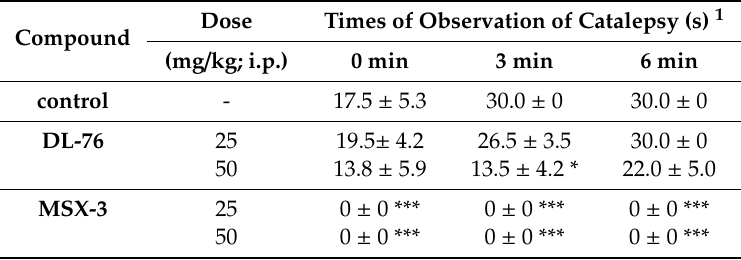
Table 3. Antiparkinsonian activity of DL76 in the bar test.